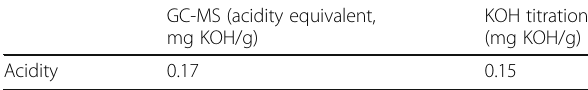
Table 12 Acidity of a light hydrocarbon liquid,